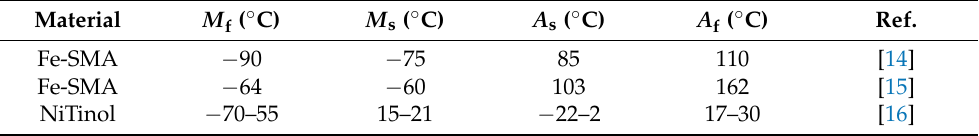
Figure 2. Schematic definition of thermal-induced martensitic transformation of Fe-SMA. ζ denotes the maximum martensite fraction, and 0 < ζ < 1. Table 2. Phase-transformation temperatures of